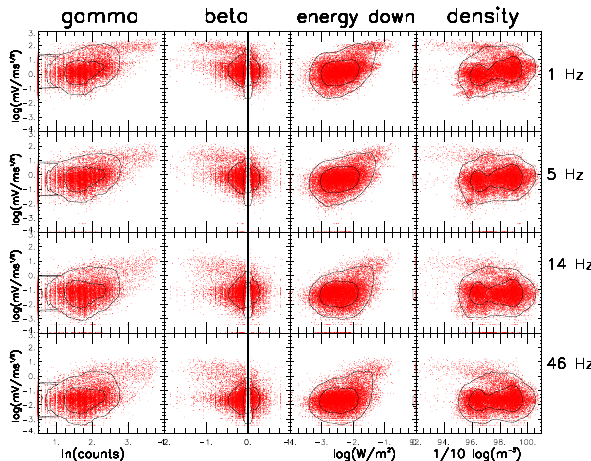
Fig. 6. Correlations between the electrons field fluctuations at 4 se- lected frequencies (1, 5, 14, and 46Hz) with particle measurements. Four types of correlations are presented; column 1 and 2, the field- aligned electron count rate at 55eV and the electron spectral shape; column 3 correlates the total downward electron energy flux below 50eV; column 4 correlates the plasma density with the field fluctu-